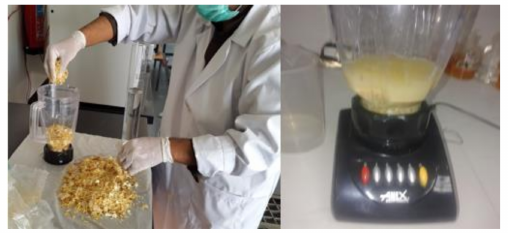
Figure 2. Preparation of substrate for anaerobic